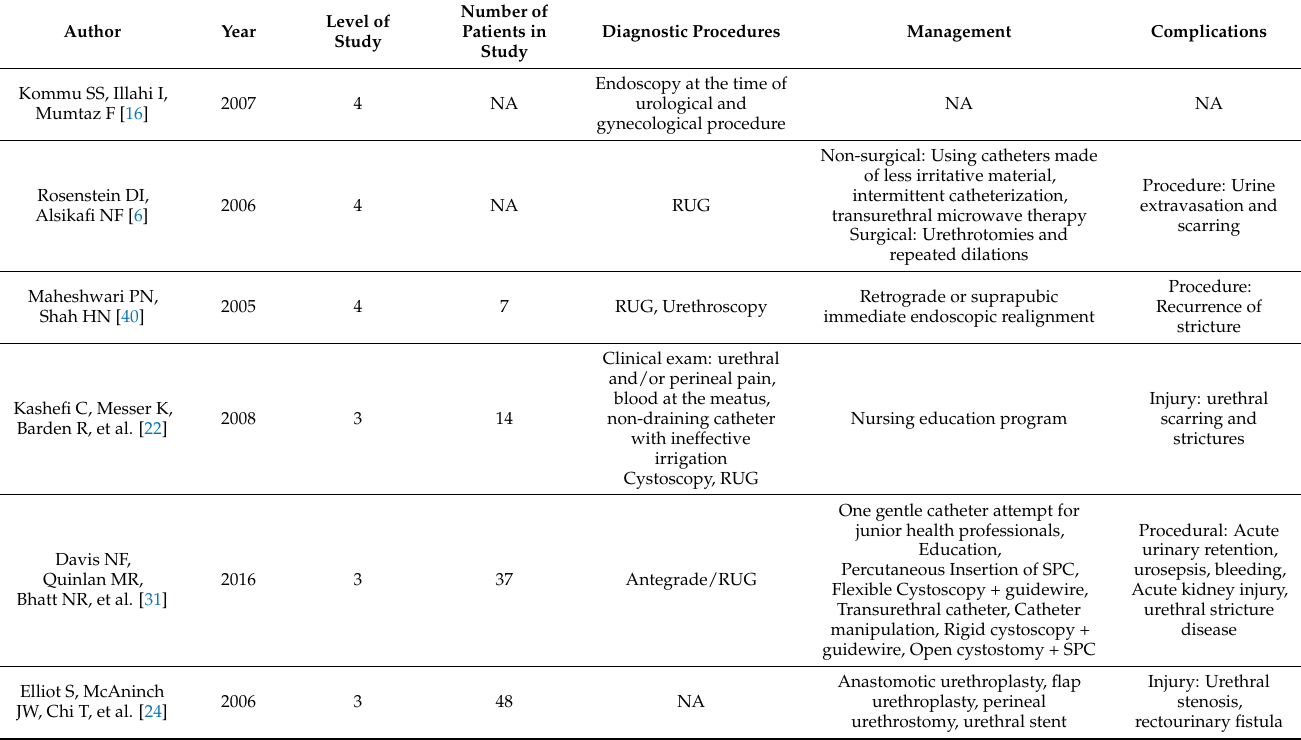
Table 1. Iatrogenic Urethral